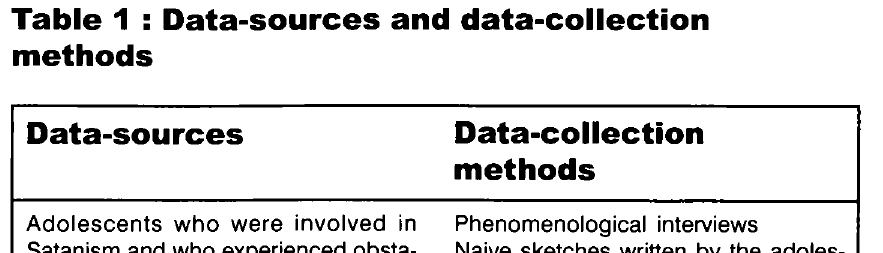
Table 1 : Data-sources and